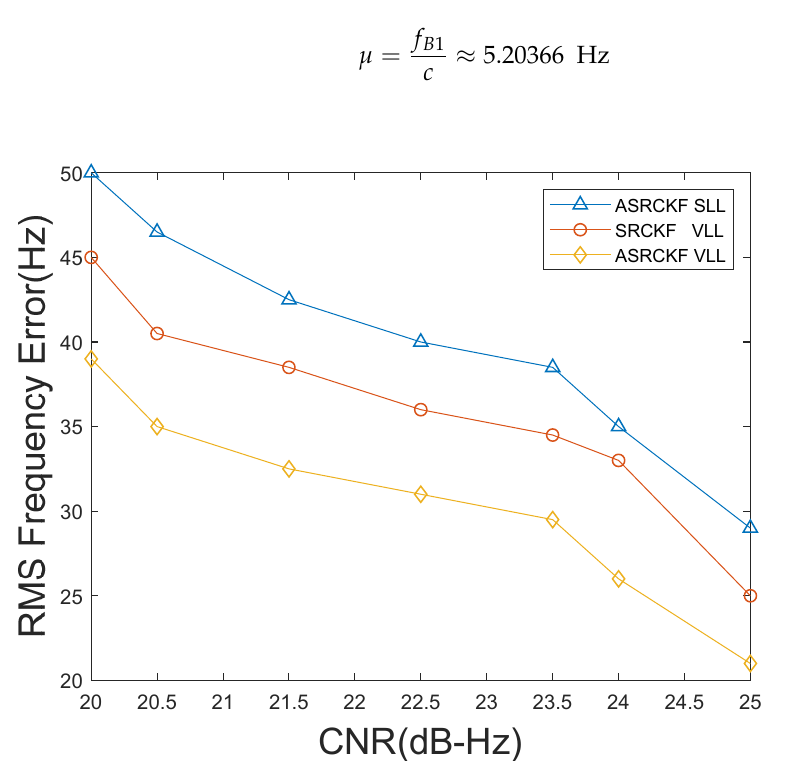
Figure 3. The relationship between RMS frequency estimation error and CNR. Figure 3 shows the relationship curve between the RMS frequency error and CNR. It can be seen from Figure 3 that, compared to SRCKF VLL and ASRCKF SLL, the ASRCKF VLL has a significant improvement in frequency tracking accuracy. When C/N 0 = 21.5, the tracking accuracy of the ASRCKF VLL is 6 dB higher than that of the SRCKF VLL and 10 dB higher than that of the ASRCKF SLL. When C/N 0 = 22.5, the mean square error of the frequency estimation of the ASRCKF VLL is 31 Hz, which is 5 dB higher than that of the SRCKF VLL and 9 dB higher than that of the ASRCKF SLL, but as the carrier-to-noise ratio C/N 0 increases, this improvement gradually